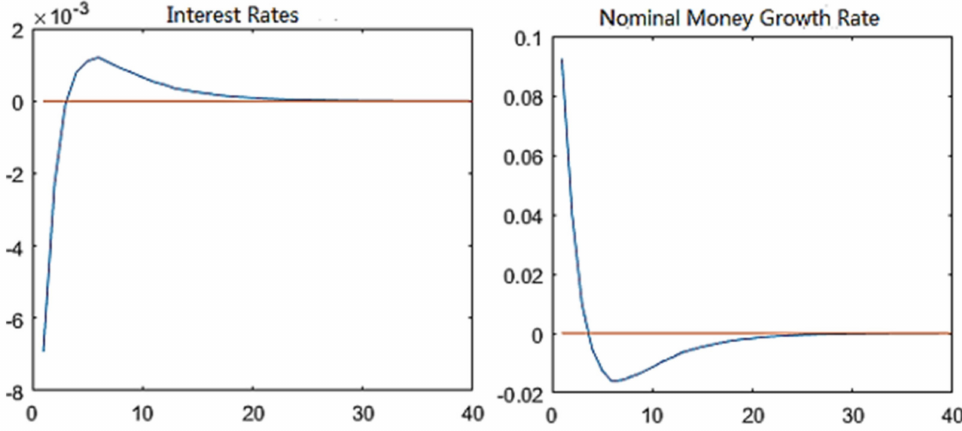
Figure 5. Comparisons between price and impulse response of quantitative monetary policy (ex- tended model; e-money restraint